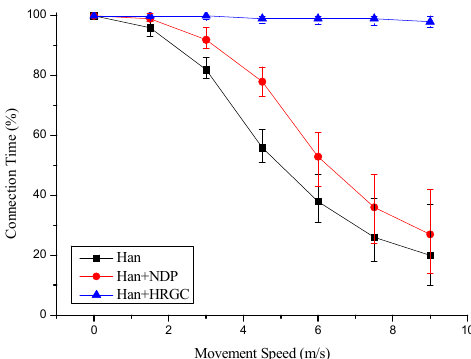
Figure 5. Connection time vs. movement speed of mobile